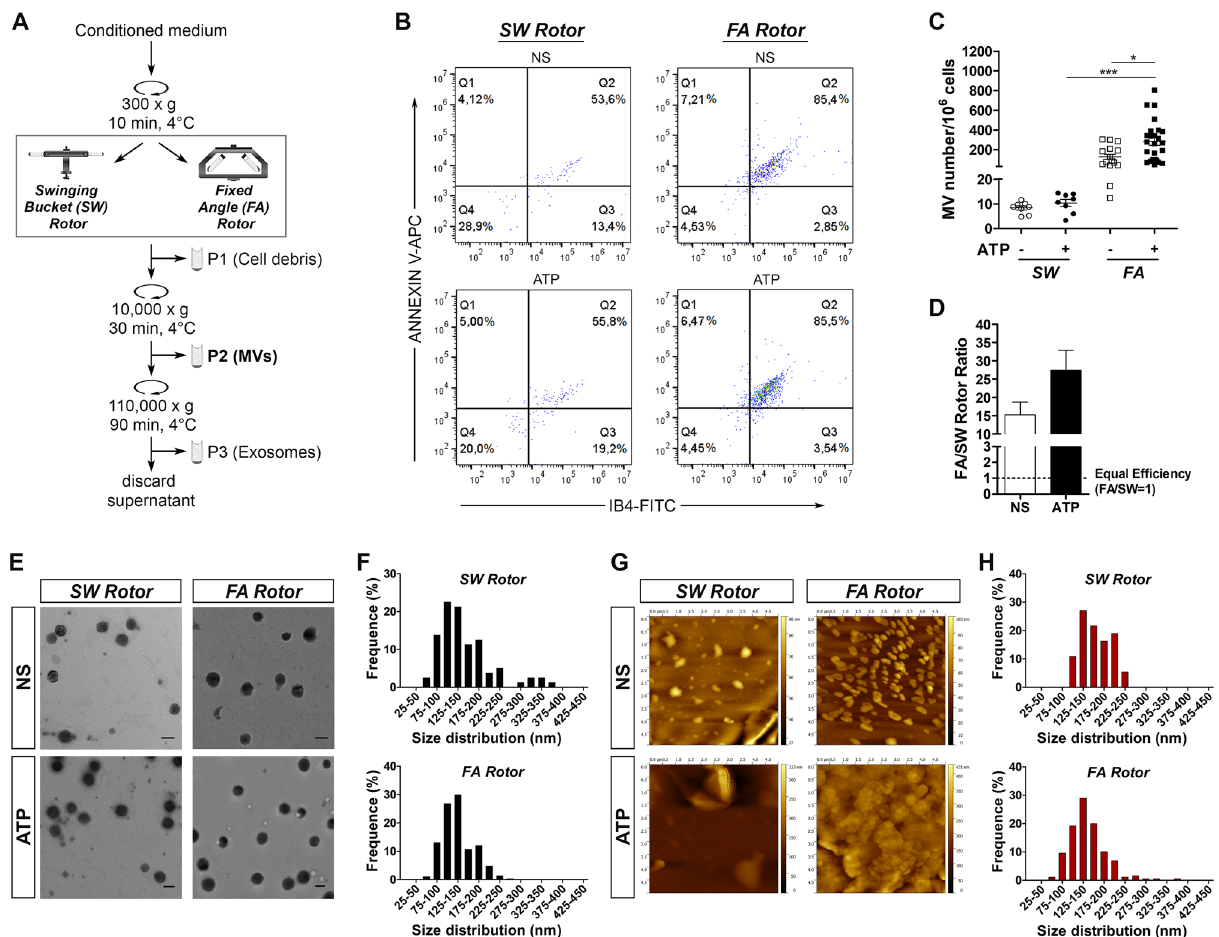
Figure 1. The rotor type employed during the first centrifugation step of the isolation protocol affects the MV recovery. ( A ) Flow chart of the differential centrifugation protocol. ( B ) Flow cytometry analysis (FlowJo, version 10) so of IB4/Annexin V double-stained MVs isolated from untreated (NS) and ATP-stimulated CHME-5 microglia cells adopting SW or FA rotor during the first centrifugation step. ( C ) Quantification of IB4/Annexin V + MVs isolated using the SW or the FA rotor in NS and ATP conditions as measured by flow cytometry. Data are presented as mean ± SEM, * p < 0.05, *** p < 0.001, ANOVA with Bonferroni post hoc test (GraphPad Prism, version 5). ( D ) FA to SW rotor ratio from MV quantification as shown in ( C ) calculated as (FA-MV number/10 6 cells)/(SW-MV number/10 6 cells). Data are reported as mean ± SEM (GraphPad Prism, version 5). ( E , G ) Transmission electron microscopy (TEM) and atomic force microscopy (AFM) of isolated MVs for SW and FA protocol, in NS and ATP conditions. Scale bars 200 nm. ( F , H ) Size distribution of isolated MVs in ATP condition determined from TEM ( F , SW mean size of 155.4 ± 6.6 nm, n = 100; FA mean size of 133.8 ± 2.1 nm, n = 250) and AFM ( H , SW mean size of 173 ± 11.5 nm, n = 50; FA mean size of 154.3 ± 2.8 nm, n = 300) images using Image J